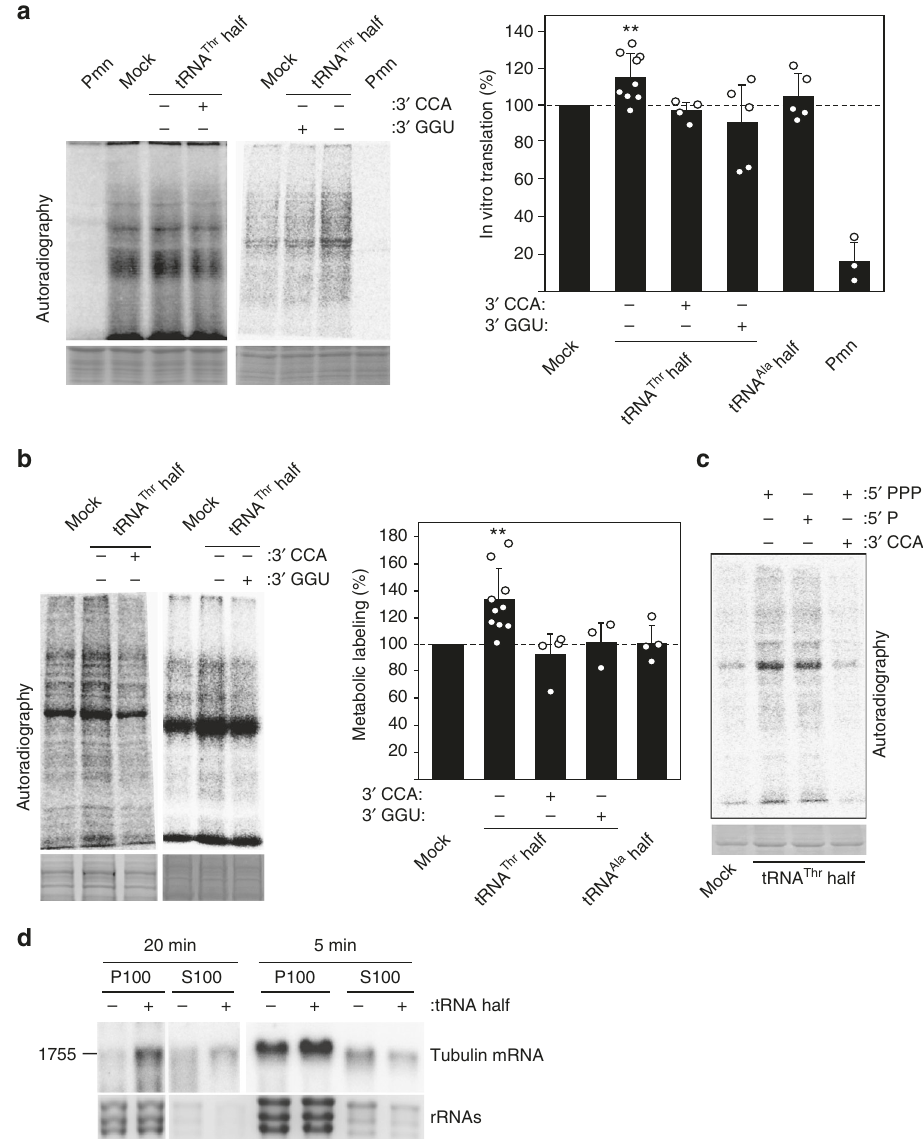
Fig. 5 The tRNA Thr 3 ′ -half stimulates translation in vitro and in vivo. a On the left, the autoradiographs of two representative SDS polyacrylamide gels of in vitro translation assays performed in the absence (mock) or in the presence of in vitro transcribed tRNA Thr 3 ′ half, either containing a 3 ′ -CCA or 3 ′ -GGU end ( + ) or lacking it ( − ), are shown. The mean and standard deviations of four to nine independent in vitro translation experiments in the absence (mock) or presence of tRNA halves (either originating from tRNA Thr of tRNA Ala ) are shown on the right graph. Addition of the translation inhibitor puromycin (Pmn) serves as speci fi city control for the assay ( n = 3). b On the left, the autoradiograph of two representative gels of in vivo translation reactions performed in the absence (mock) or in the presence of electroporated tRNA Thr 3 ′ halves, either containing a 3 ′ -CCA or 3 ′ -GGU end ( + ) or lacking it ( − ), are shown. Quanti fi cation (mean and standard deviation) of three to ten independent metabolic labeling experiments in the absence (mock) or presence of introduced tRNA halves (either originating from tRNA Thr of tRNA Ala ) is shown on the right graph. c Autoradiograph of an in vivo translation assay using electroporated tRNA Thr 3 ′ halves containing different chemical groups at the 5 ′ end. A representative gel of in total four independent experiments is shown. 5 ′ -PPP: 5 ′ triphosphate; 5 ′ -P: 5 ′ monophosphate. 3 ′ -CCA: indicates the presence or absence of a 3 ′ CCA tail. Signi fi cance in a and b according to paired Student ’ s t -test: ** P ≤ 0.01. d Abundance of tubulin mRNA (1755 nucleotides; see Supplementary Figure 17a) associated with ribosomes (P100) during T. brucei in vitro translation reactions in the presence or absence of the tRNA Thr 3 ′ half was monitored by northern blot analysis ( n = 2). S100 indicates the respective post-ribosomal supernatants. Reactions were stopped either after 5 or 20 min of incubation. In all fi gures either Coomassie stained protein gels or EtBr staining of RNA gels (bottom panels) serve as loading